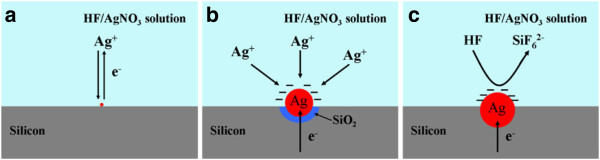
Mechanism diagram of Ag deposition on the Si surface in HF/AgNO3 solution. (a) Formation of Ag nucleation. (b) Ag particle growth and Si substrate oxidation. (c) Ag particles trapped in the pits formed by the etching of SiO2 around it by HF.